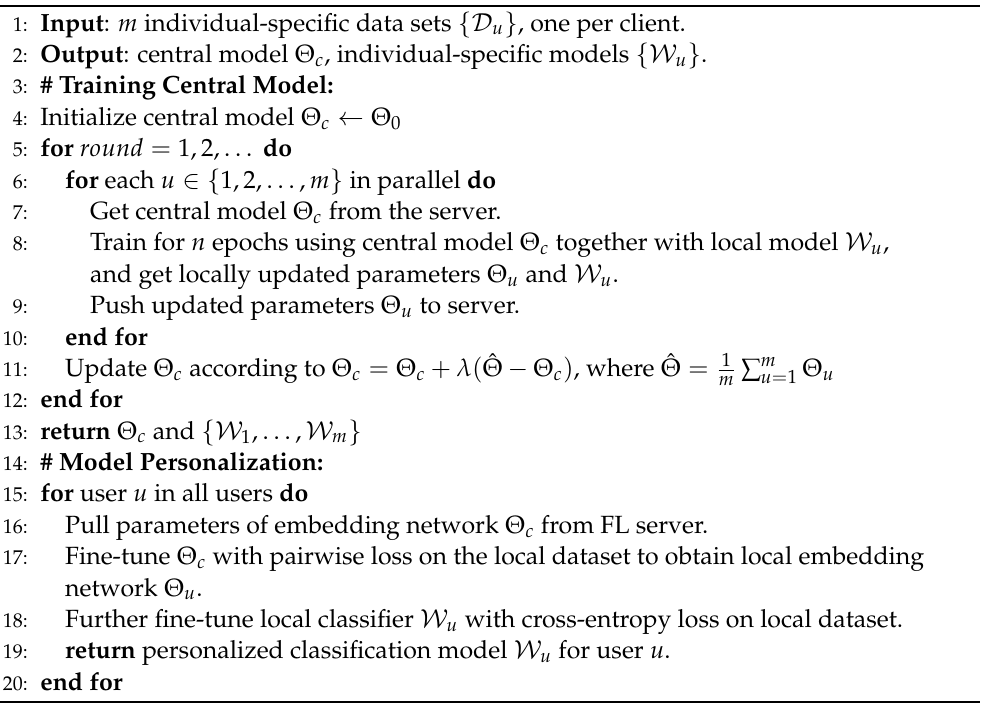
Algorithm 1: Federated Multi-Task Attention for Diversity Mental activity